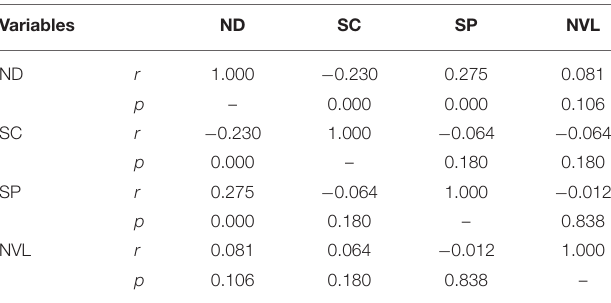
TABLE 4 | Correlations of environmental factors on the physical